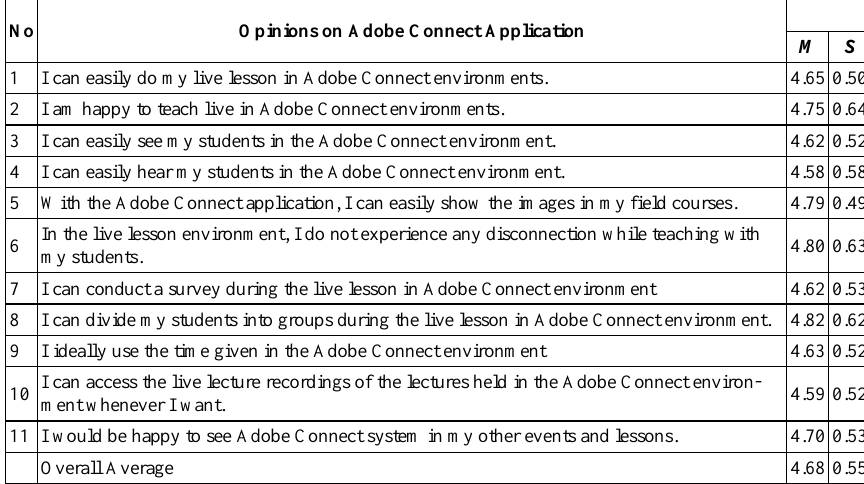
Table 6. University students’ opinions on the Adobe Connect